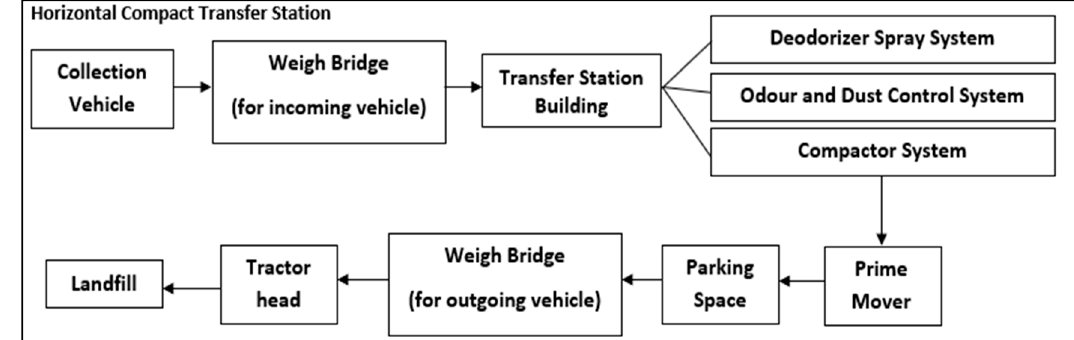
Figure 3. Leachate Treatment Plant (LTP) unit operation. Data from National Solid Waste Management Department (2012).